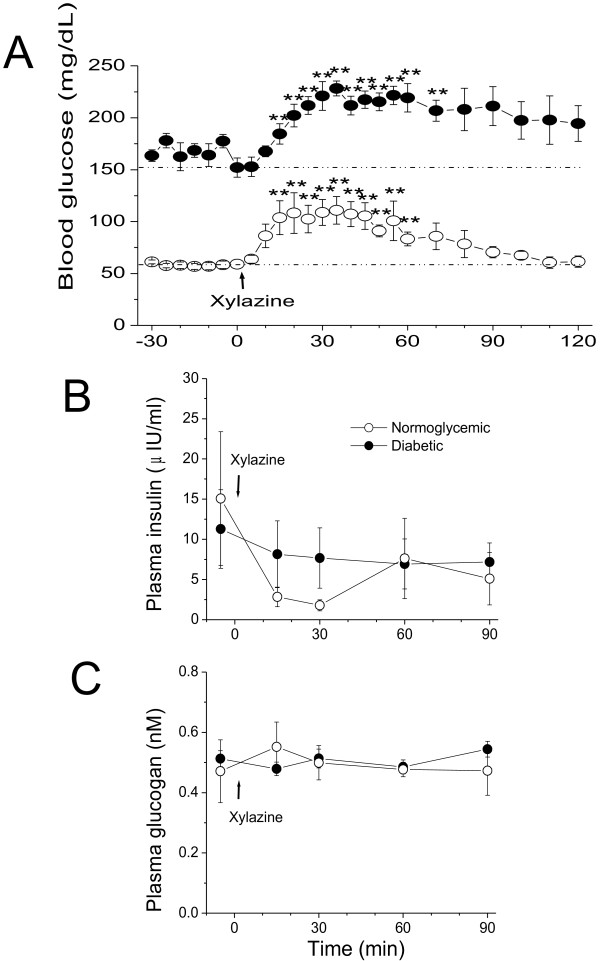
Hyperglycemic effects of xylazine in fasted, ketamine-anesthetized cynomolgus monkeys. Panel A shows the time-dependent effects of xylazine in normoglycemic (open circle, n = 5) and insulin-dependent diabetic (solid circle, n = 5) monkeys. The dotted lines show the pre-xylazine glucose levels in normoglycemic and insulin-dependent diabetic monkeys. The time-dependent effects of xylazine on plasma insulin and glucagon are shown in panel B and C, respectively. ↑, the time point that xylazine (1–2 mg/kg) was injected intramuscularly. **, p < 0.01; vs. the baseline level at time zero.